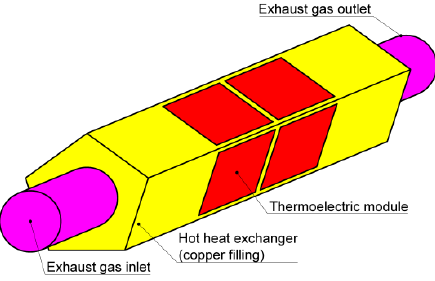
Fig. 2. Thermoelectric module